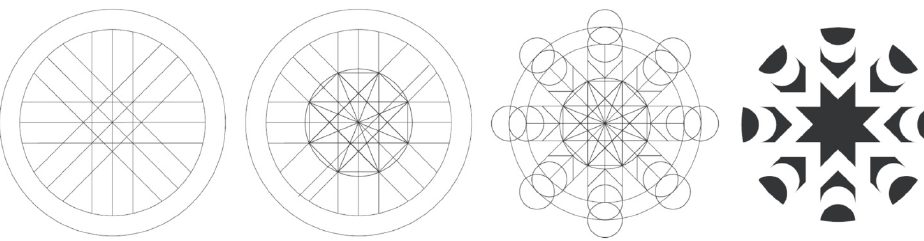
Figure 13. Common